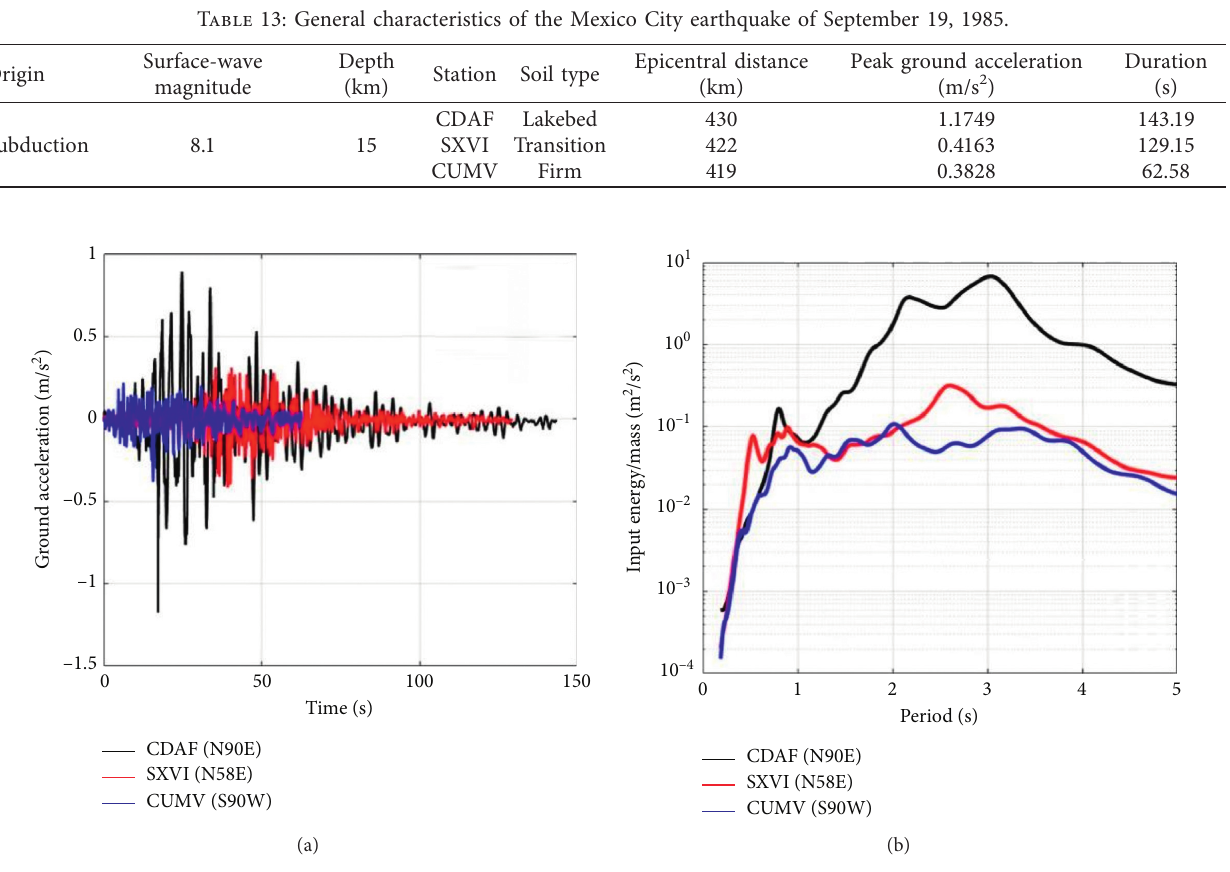
Table 12: Geometry and dynamic properties of a PTMD attached at z